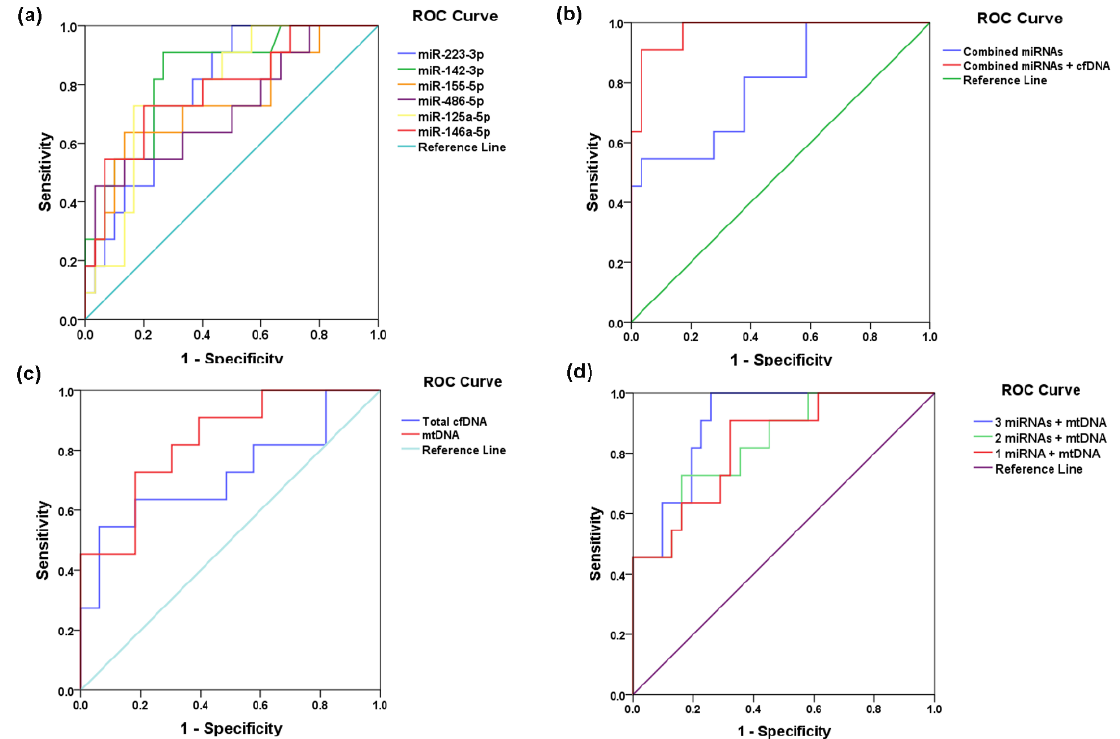
Figure 8. Receiver operating characteristic (ROC) curves for predictive potentials of individual and combined models for major adverse cardiovascular events (MACE) using: ( a ) individual miRNAs, ( b ) multivariate models of all 6 miRNAs and with cell-free DNA (cfDNA and mtDNA) levels, ( c ) total